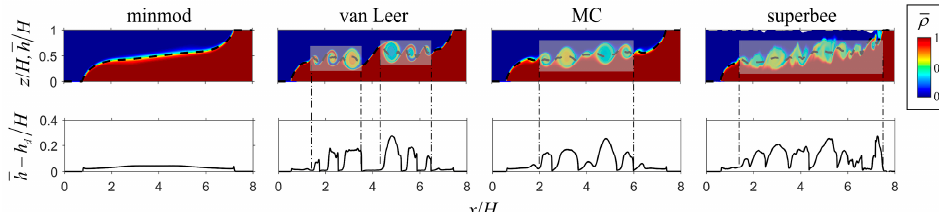
Figure 16. The horizontal distribution of h / H (the dashed lines in upper panels) and the difference ( ) h − h d / H (lower panels) at t = 10 T for the constant-viscosity cases of the lock-exchange problem with the grid resolution N x × N z = 800 × 100. The background images in the upper panels are the density distributions. The shaded areas represent the mixing regions.